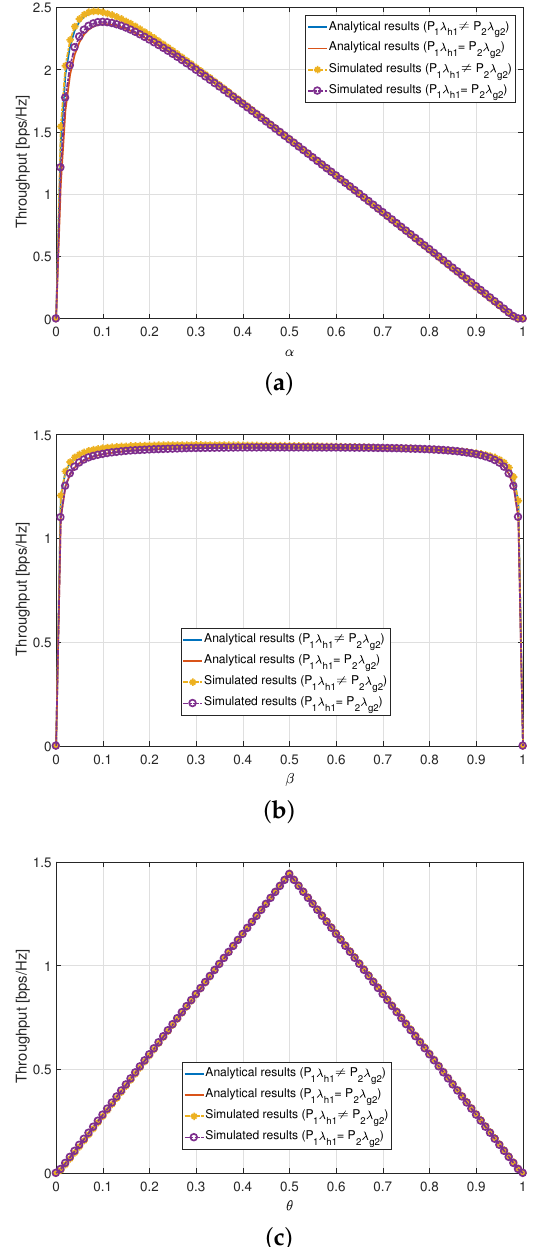
Figure 4. The system throughput as a function of α , β , and θ . Other parameter σ 2 = 0.001 W. ( a ) Throughput as a function of α . ( b ) Throughput as a function of β . ( c ) Throughput as a function of θ